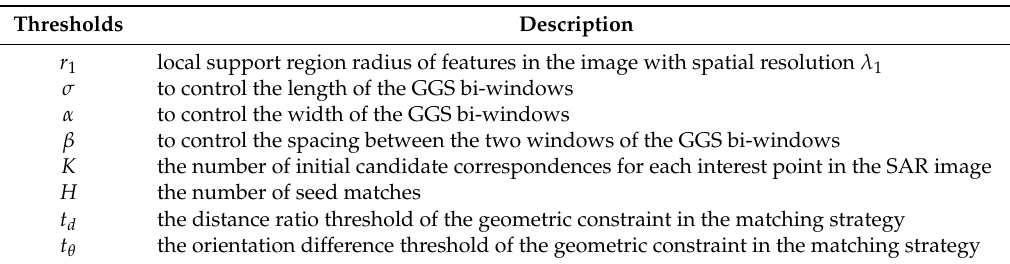
Table 3. Thresholds of the proposed